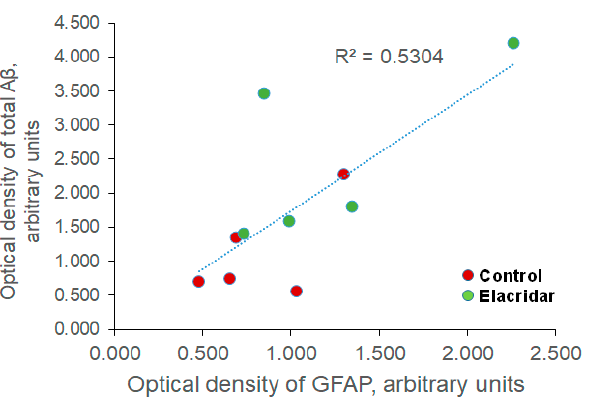
Figure 8. Correlation analysis between optical density changes in GFAP and total A β levels re- vealed a positive correlation between GFAP and total A β , as demonstrated by the coefficient of determination (R 2 ). n = 5 mice/treatment group were used. Optical density is presented in arbi- trary